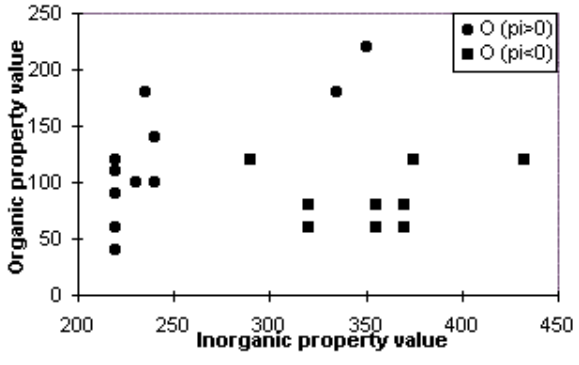
Figure 2. Organic property value versus inorganic property value of amino